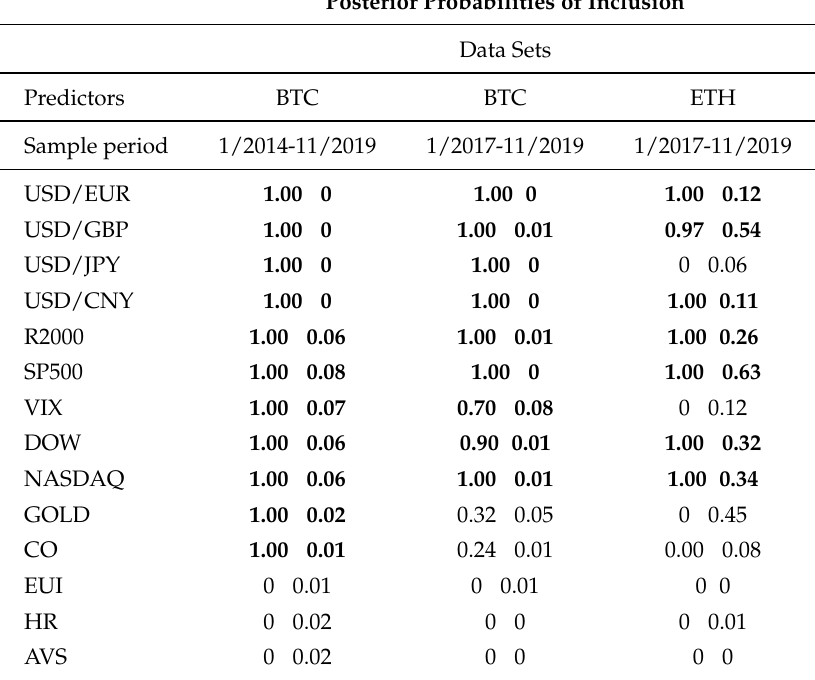
Table 6. Posterior probabilities of inclusion of the explanatory variables. The first value in each cell is the posterior probability of inclusion in the mean equation and the second the probability of inclusion in the transition probabilities of the underlying Markov process. The probabilities of the variables that are included in the median probability model, i.e., variables with probability above 0.5 in either the mean equation or the logistic regression equation are highlighted with